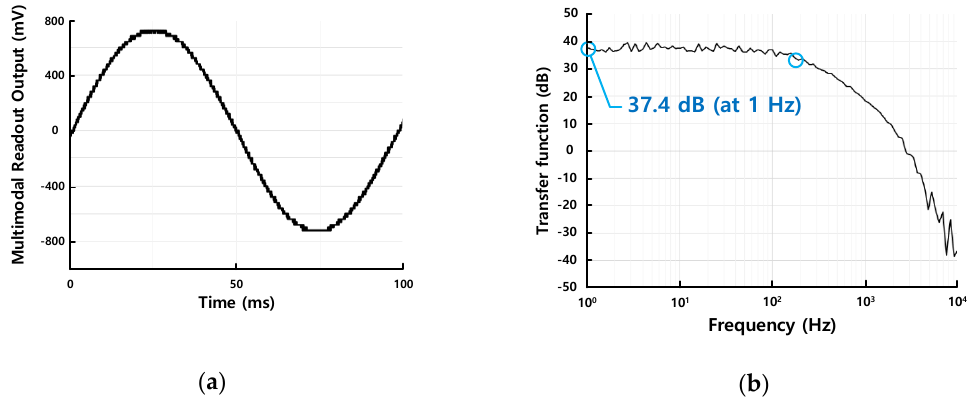
Figure 9. ( a ) Output in the voltage-sensing mode. ( b ) Transfer function in the voltage-sensing mode.